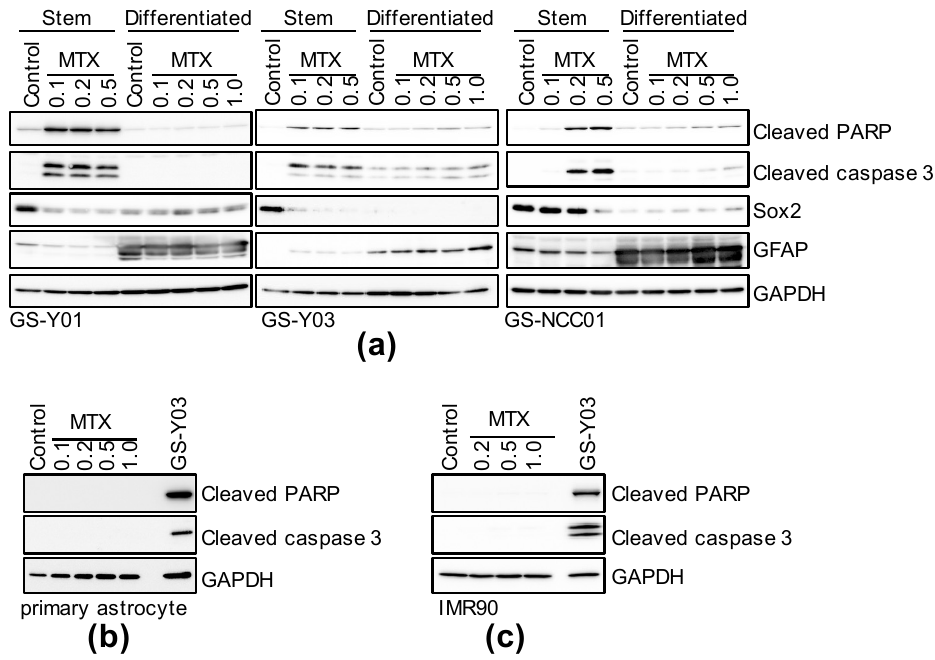
Figure 2. MTX induces caspase-activated cell death in GSCs, but not in differentiated GSCs. GSCs (GS-Y01, GS-Y03, GS-NCC01; Stem or Differentiated, ( a )), mouse primary astrocytes ( b ), and IMR90 ( c ) treated with the indicated concentrations ( µ M) of MTX for 3 days or control-treated were analyzed by immunoblotting for the indicated proteins. “GS-Y03” in ( b , c ) denotes GS-Y03 cells treated with 0.2 µ M MTX for 3 days. Representative images of two independent biological replicates.